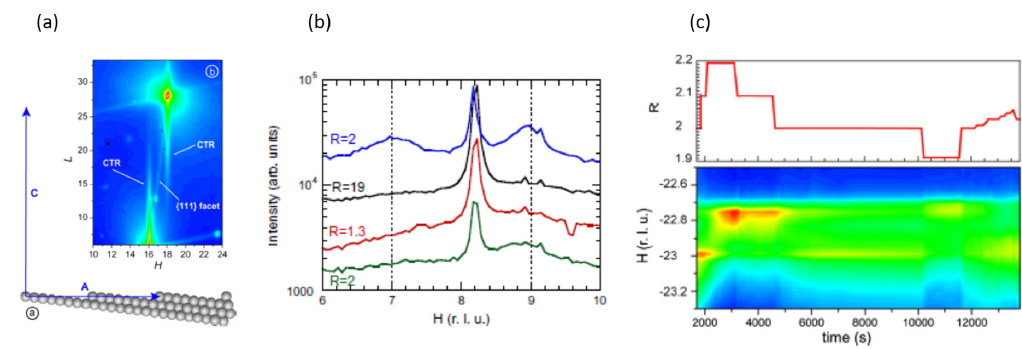
Figure 7. ( a ) Schematic illustration of the origin of diffraction features from the vicinal (997) Pt surface along with an Maxipix image of the diffraction obtained from the fresh surface showing the relevant crystal truncation rods (CTR) and scattering from the 111 surface facets. ( b ) Effect of pressures (200 mbar) of O 2 and CO at different stoichiometric ratios ( R ) on the Surface X-ray diffraction (SXRD) collected at fixed K and L but variable H , and at 763 K. ( c ) Temporal dependence of the SXRD as a function of small variations in ( R ) (1.9 ≤ R ≤ 2.2) showing the effects of the reaction environment on the balance between steps and terraces on the Pt(111) surface. Reproduced with permission from J.